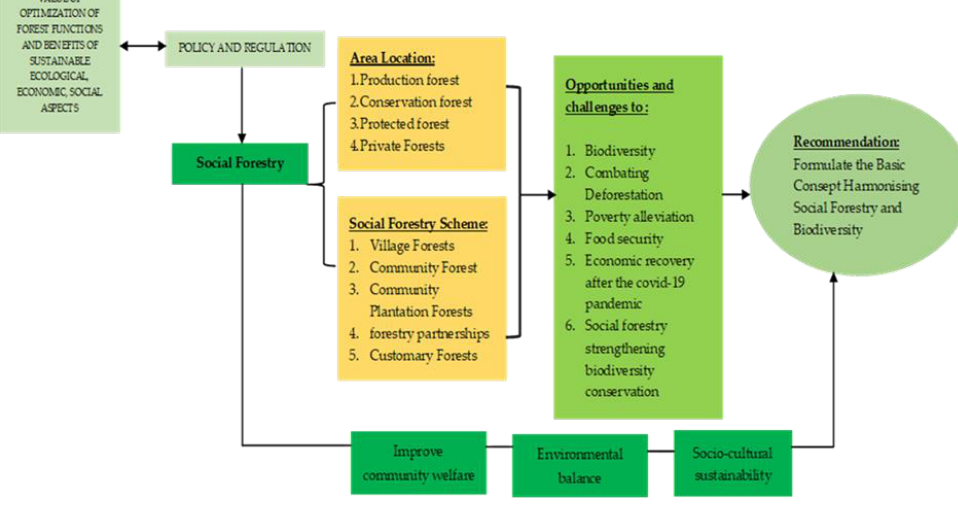
Figure 1. Conceptual logical framework.